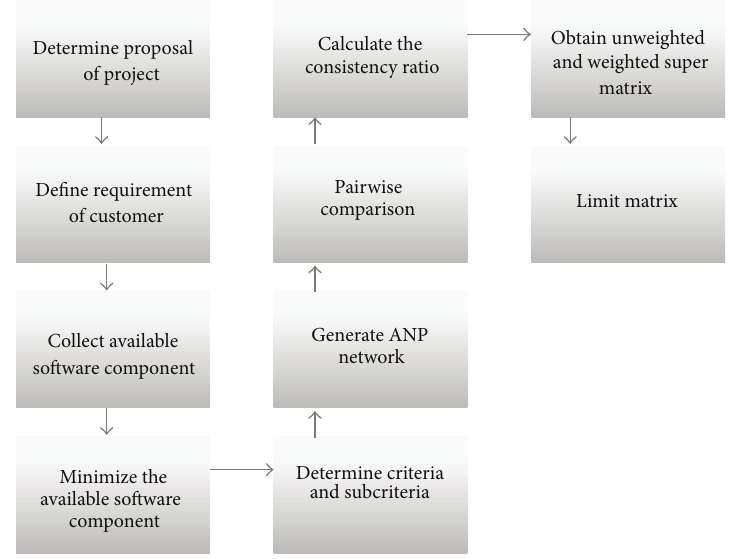
Figure 3: Phases involved in the proposed method based on